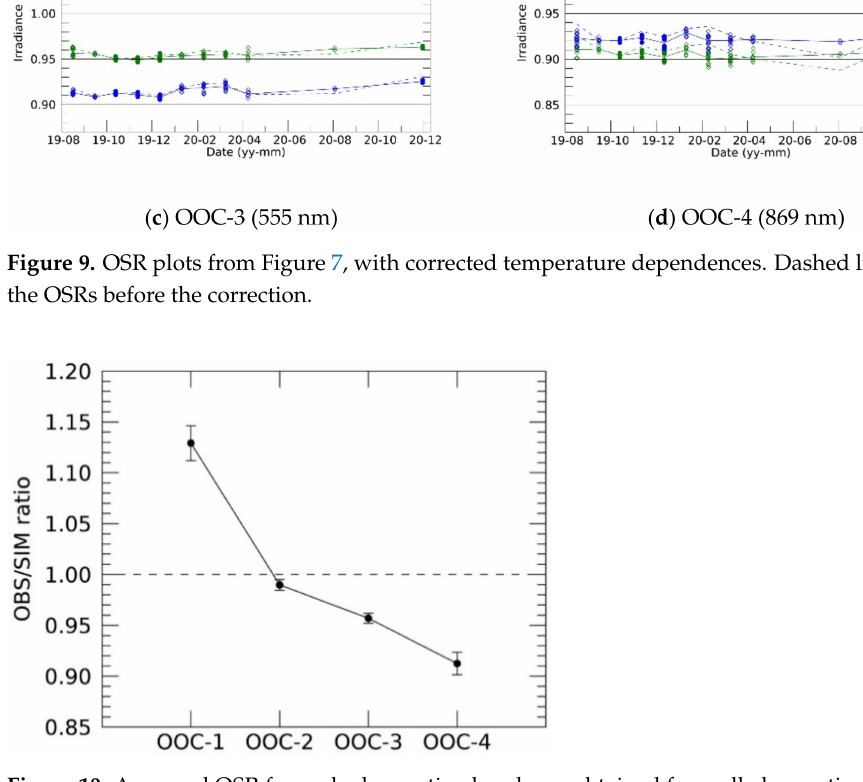
Figure 10. Averaged OSR for each observation band was obtained from all observation. Horizontal dashed line indicates the expected ratio based on the ROLO model, and the error bar indicates the standard deviation, in which the OOC’s temperature dependence is